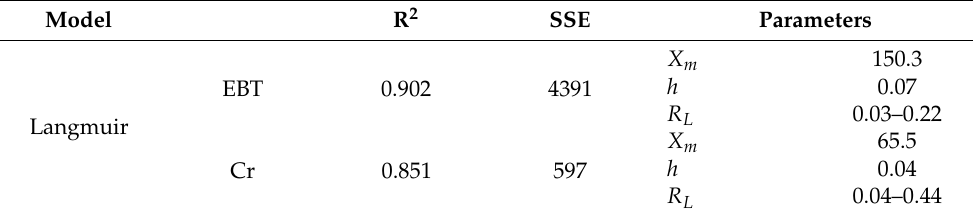
Table 4. Statistical parameters (R 2 and SSE) and isotherm parameters of the investigated isotherms on EBT and Cr removal by Mg-Ca-Al-LDO